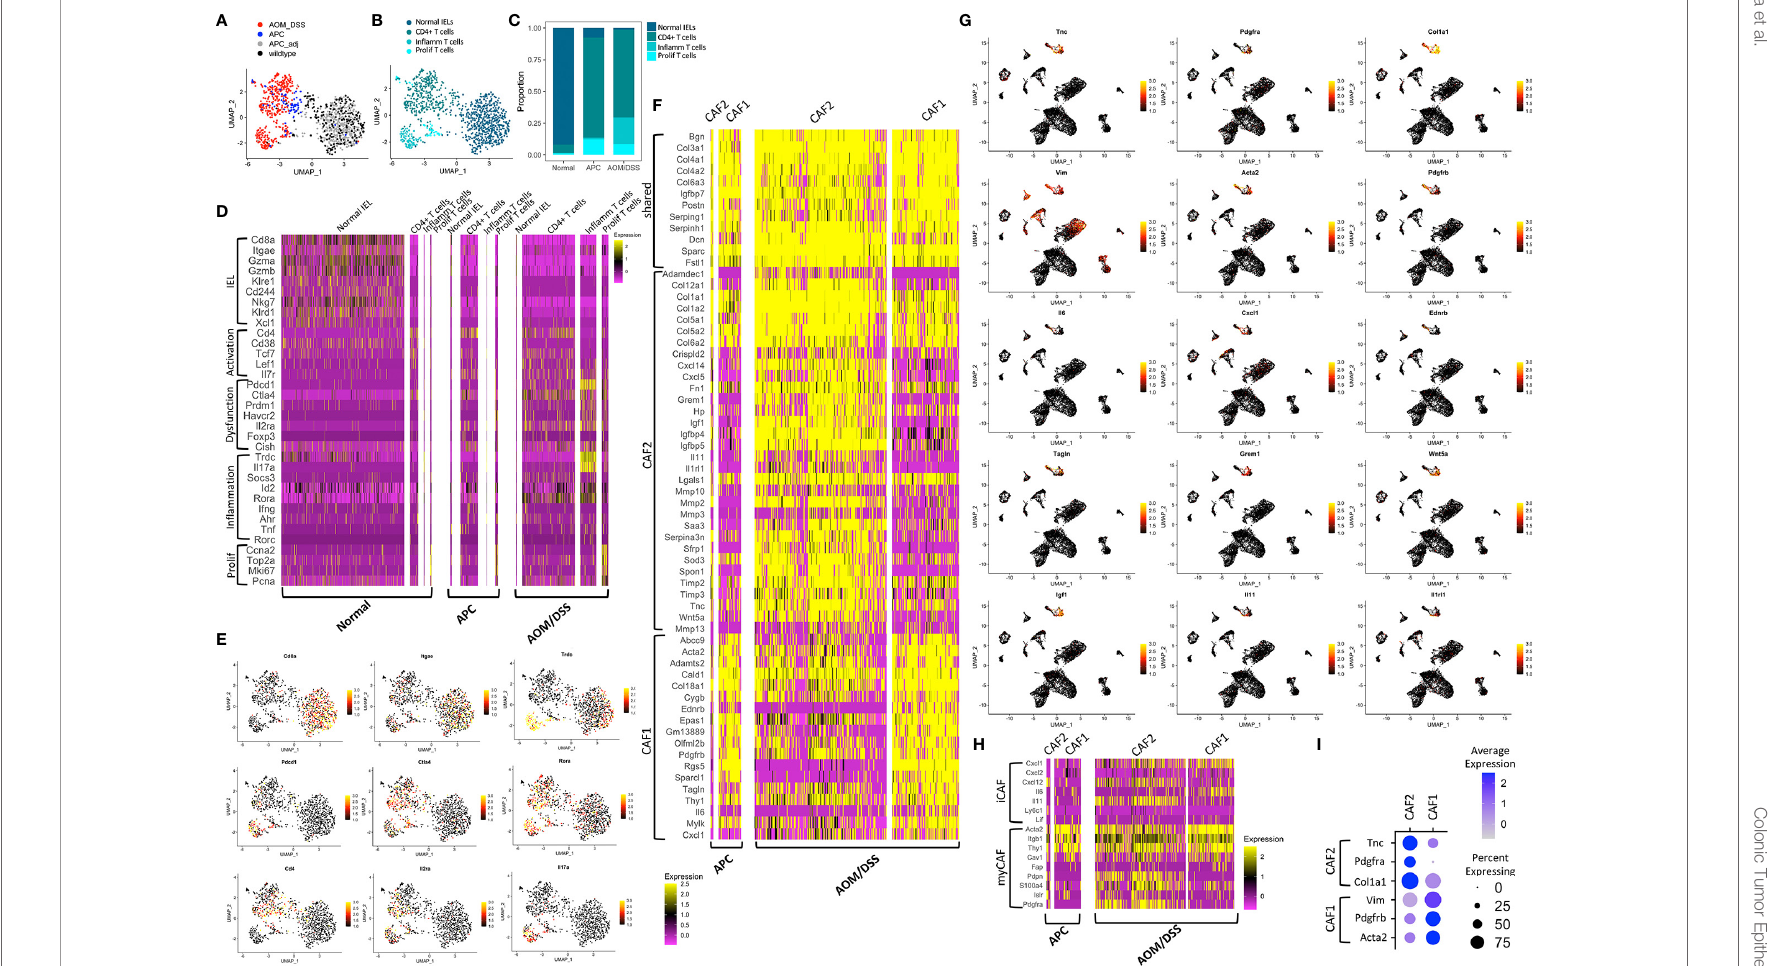
FIGURE 2 | Transcriptomic differences among microenvironmental cell types in normal colonic, APC tumor, and AOM/DSS tumor samples. UMAP co-embedding of the T cell cluster from wildtype, APC tumor, APC adjacent normal, and AOM/DSS tumor scRNA-seq samples with (A) sample type overlay (B) and cell type clustering overlay, by color. (C) Bar graph of T cell type proportions, broken down by subcluster and sample type in scRNA-seq data. (D) Heatmap of select T cell subtype marker expression in scRNA-seq data within the T cell clusters, split by sample type. Columns represent single cells. (E) UMAPs of scRNA-seq data with gene expression overlay, indicated by the color gradient, for select T cell subtype markers. (F) Heatmap of DEGs in fi broblast subtypes (CAF1, CAF2) in scRNA-seq data, split by fi broblast subtype and by sample type. Columns represent single cells. (G) UMAPs of scRNA-seq data with gene expression overlay, indicated by the color gradient, for select fi broblast subtype markers. (H) Heatmap of expression of markers of iCAFs and myCAFs described in literature in CAF1 and CAF2 populations in scRNA-seq data, broken down by tumor sample. Columns represent single cells. (I) Dot plot showing selected markers for fi broblast subtypes, CAF1 and CAF2, where clusters include cells from both APC tumor and AOM/DSS tumor